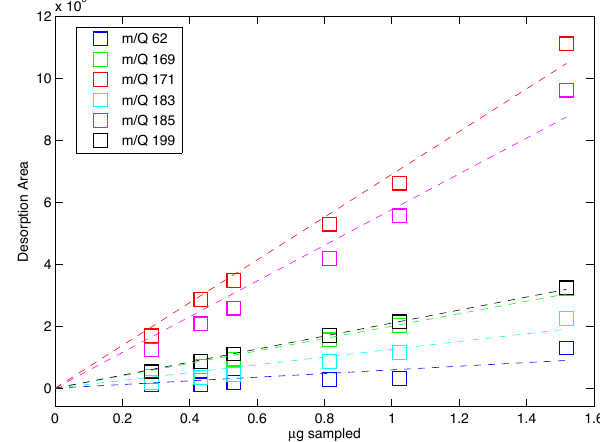
Fig. 4. Blank-corrected integrated signals measured during thermal desorption for various ion compositions plotted versus the total par- ticle mass collected on the filter. Desorbed compounds were de- tected with a quadrupole CIMS employing acetate ionization cou- pled to the FIGAERO. To change the mass loading on the filter, particle collection times were varied while sampling from the UW steady-state α -pinene ozonolysis chamber output. Particle mass concentrations were measured by an SMPS. Linear fits to the data forced through the origin are shown with the mean R 2 = 0 .